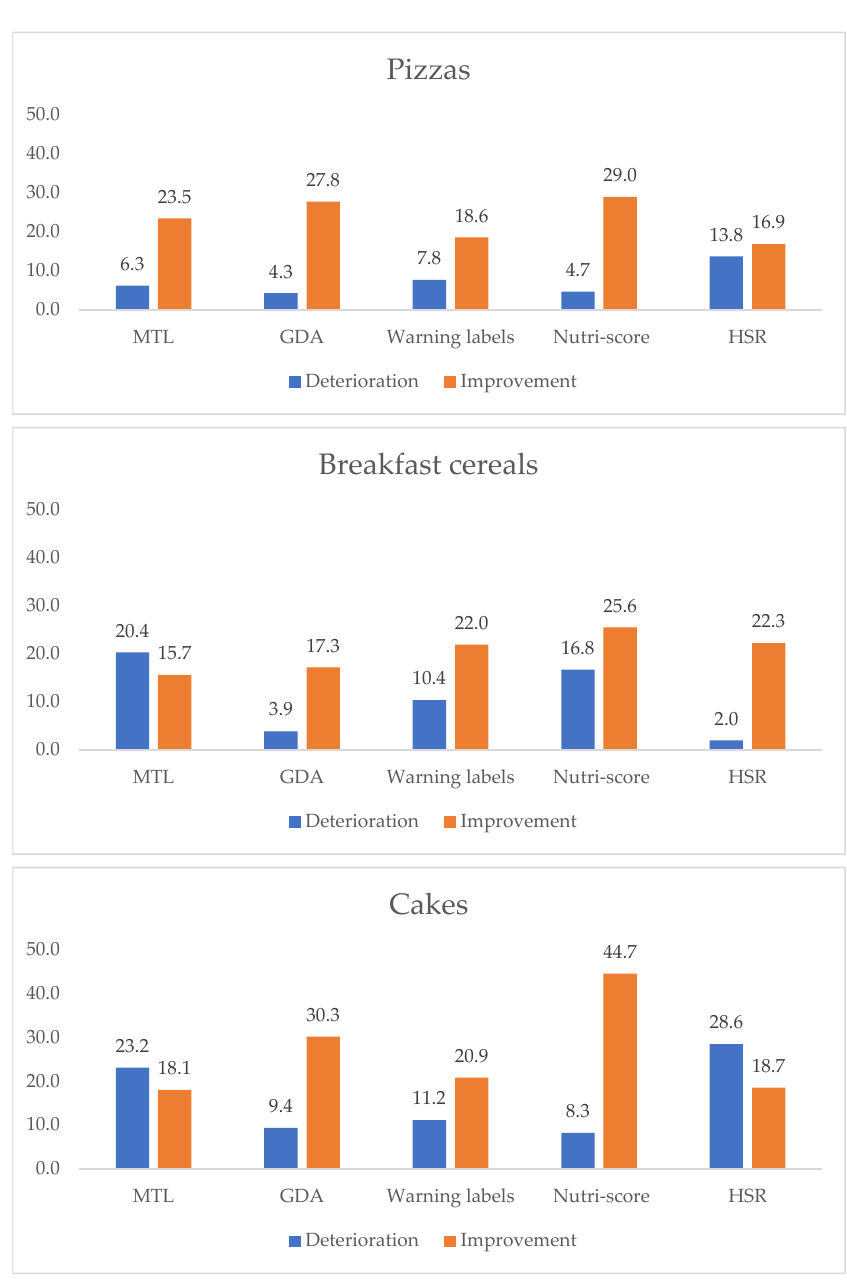
Figure 2. Percentage of participants who improved or deteriorated their food choices depending on the product category and its nutritional labeling in Greece. For all food categories and FoP labels, except the Nutri-Score, slight to moderate de- teriorations were observed compared to the GDA label. For the MTL, statistically signifi- cant deteriorations compared to the GDA were observed for all categories combined (OR = 0.71 [0.63–0.79] ( p < 0.001)), cakes (OR = 0.55 [0.46–0.68] ( p < 0.001)) and breakfast cereals